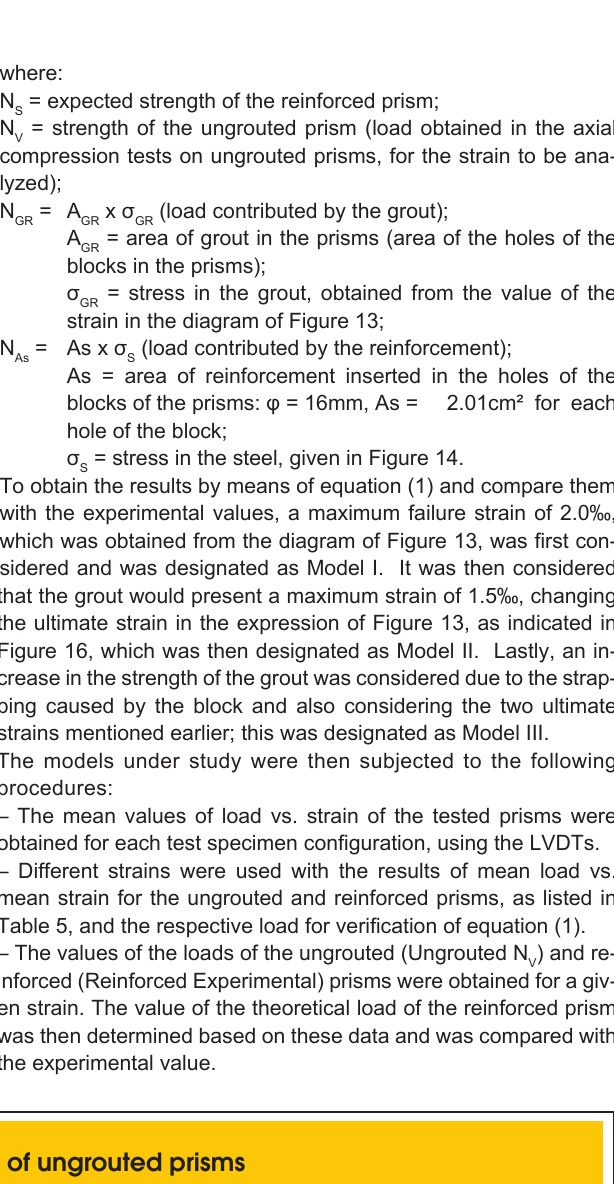
Figure 10 – Failure mode of ungrouted